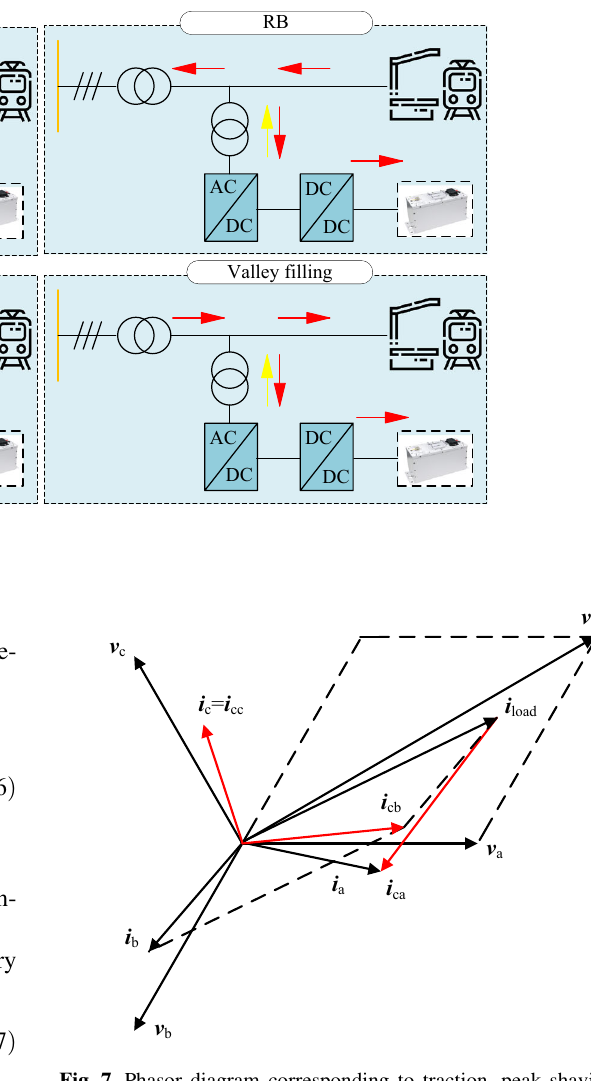
Fig. 7 Phasor diagram corresponding to traction, peak shaving and valley filling